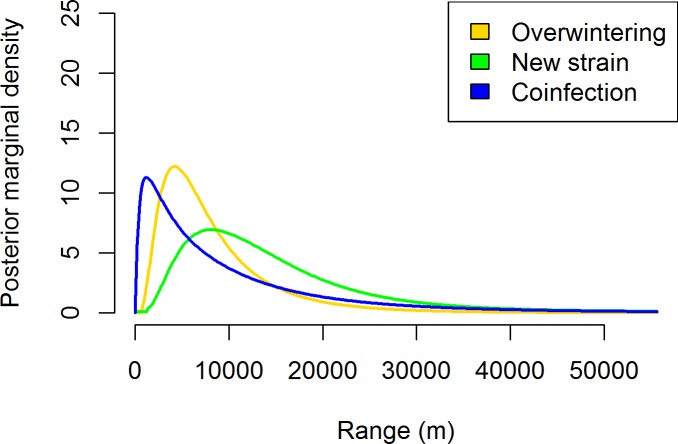
The estimated posterior distributions of the spatial ranges for the fitted spatio-temporal models described in Table 1.Range corresponds to the distance at which the spatial autocorrelation becomes negligible (smaller than 0.1).